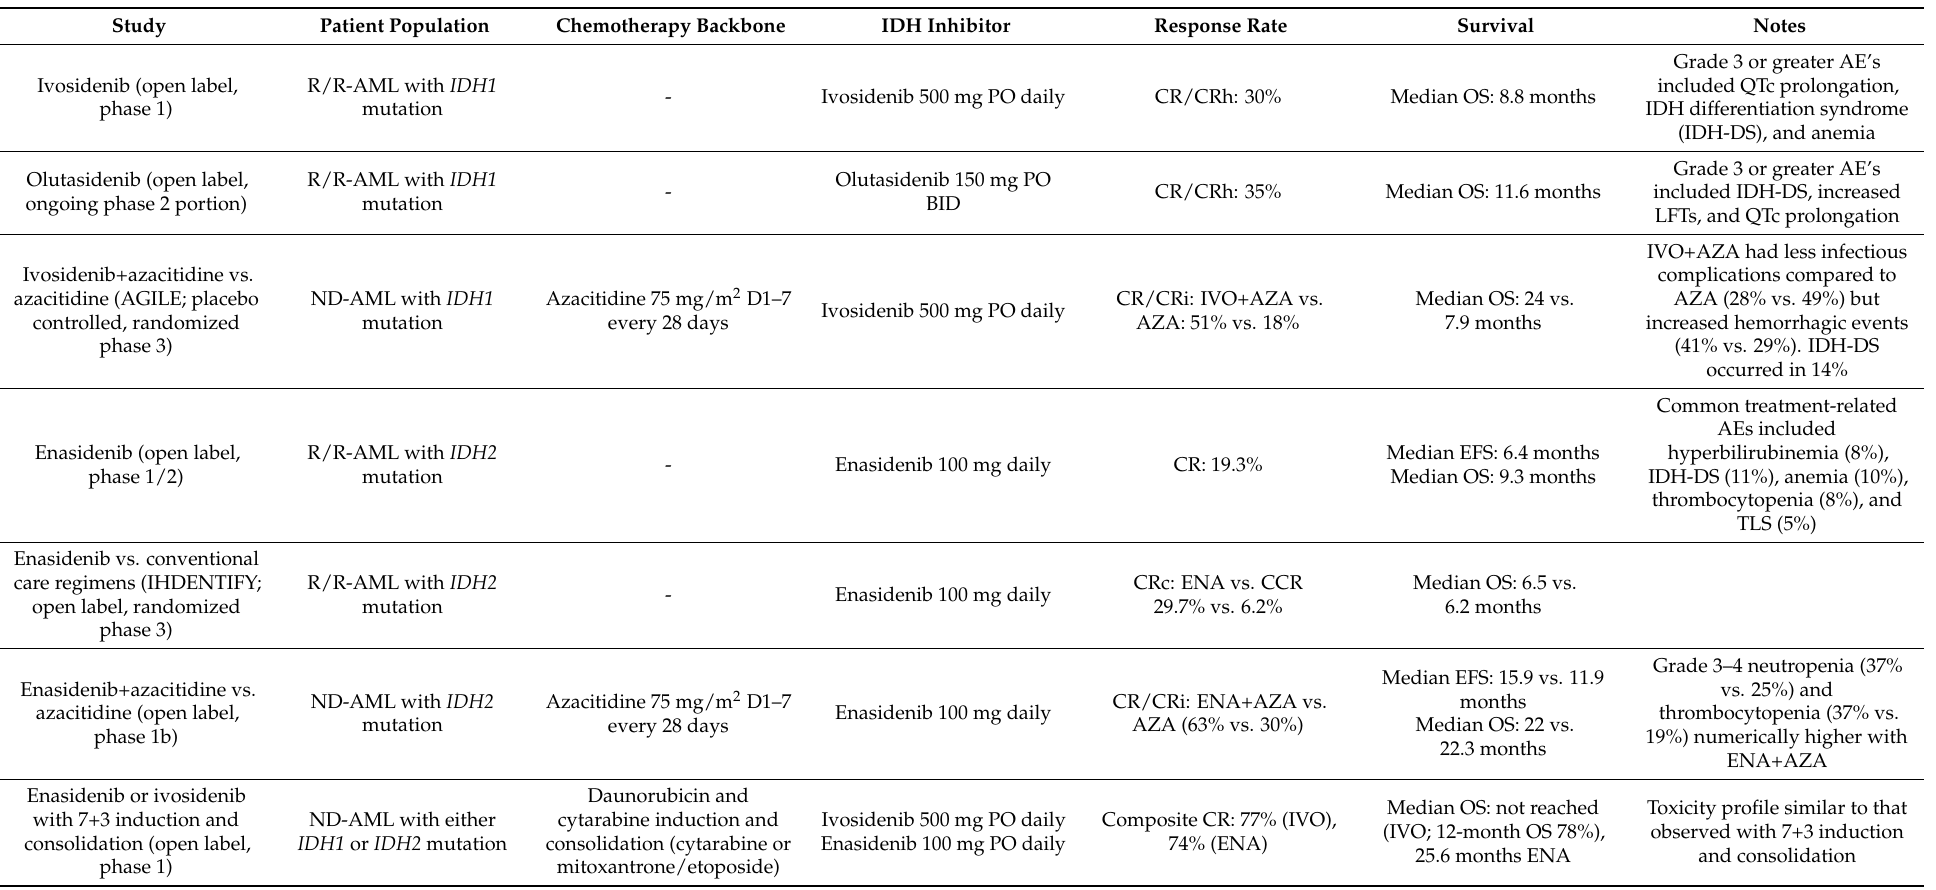
Table 2. Principal studies of IDH inhibitors for the treatment of